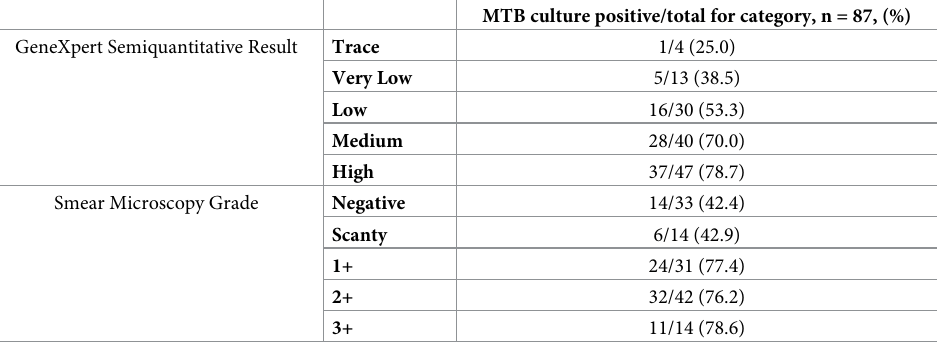
Table 6. Correlation between swab culture and smear microscopy grade or GeneXpert semiquantitative